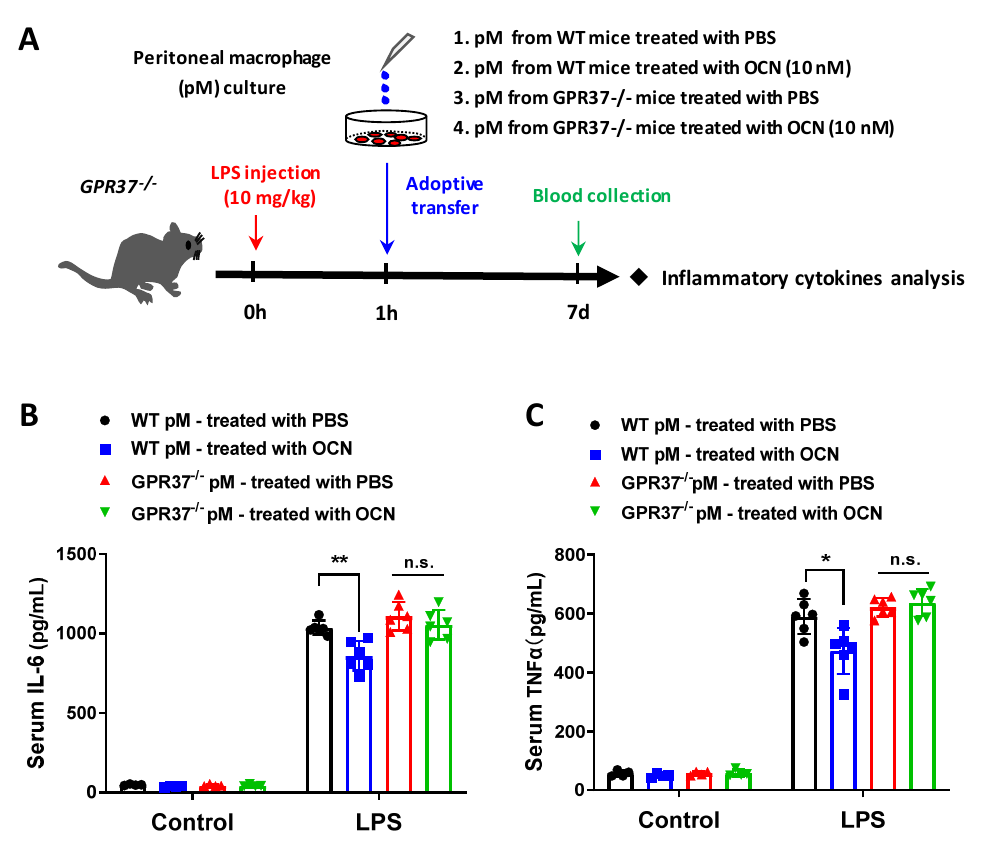
Figure 7. Adoptive transfer of OCN-treated macrophages confers protection against LPS stimulation. ( A ) Experimental design, to test whether adoptive transfer of macrophages pretreated with OCN, could attenuate LPS-induced acute inflammation. Peritoneal macrophages were isolated from WT or GPR37 − / − mice and then treated with PBS or OCN (10 nM) for 24 h, followed by a washout of OCN and an adoptive transfer of macrophages (I.P.) into GPR37 − / − mice challenged with LPS for 1 h. ( B , C ) ELISA analysis of serum IL-6 ( B ) and TNF α ( C ) levels, in GPR37 − / − mice with adoptive transfer, of macrophages derived from WT or GPR37 − / − mice. Sample sizes are indicated as dots in each column. Data are presented as mean ± SD. * p < 0.05 and ** p < 0.01, as compared to PBS; n.s. indicates not significant.